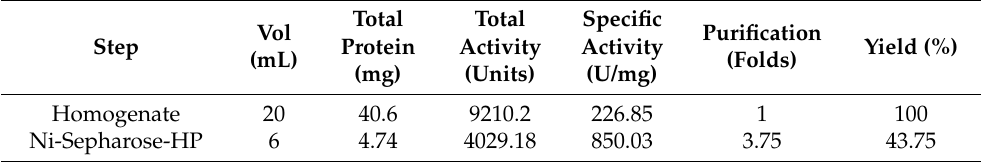
Table 1. Summary of the LIP2 purification procedure.